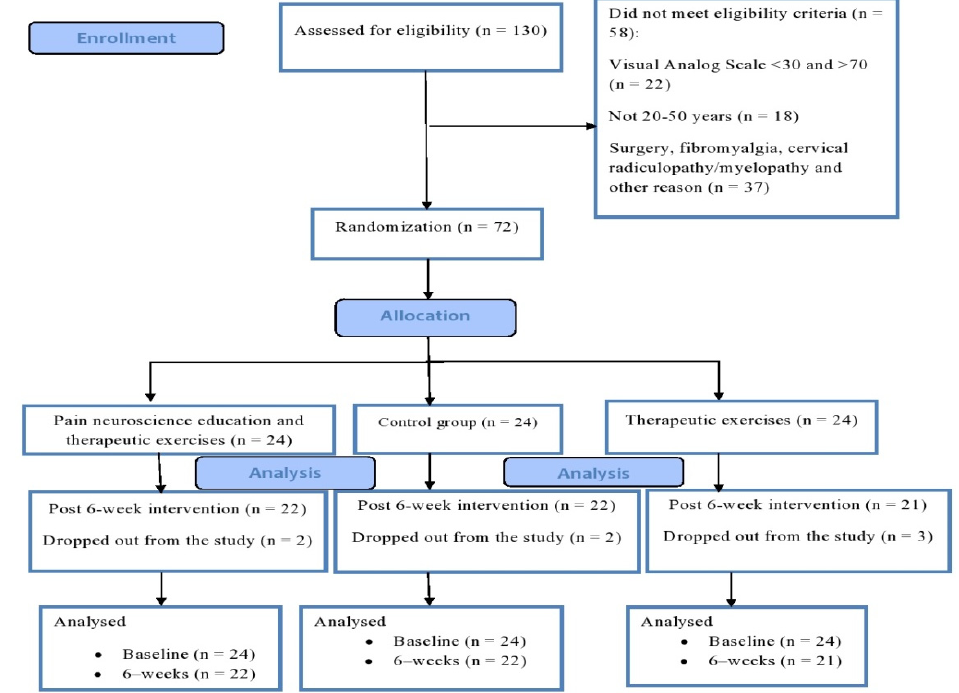
Figure 1. Flow diagram of participants’